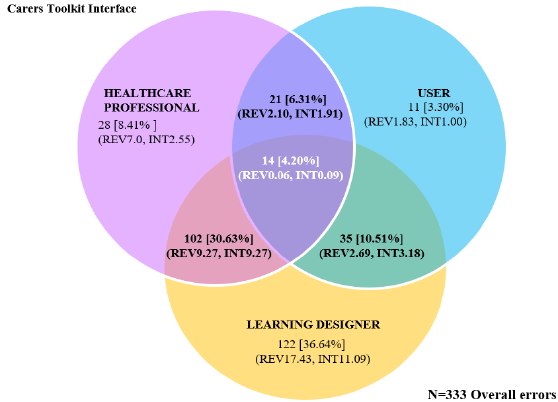
Figure 6. Overall errors interface errors identified between and across evaluator groups. Number of overall errors (%Total) (REV = average errors identified per reviewer, IN = average errors identified by reviewer group across the interface).